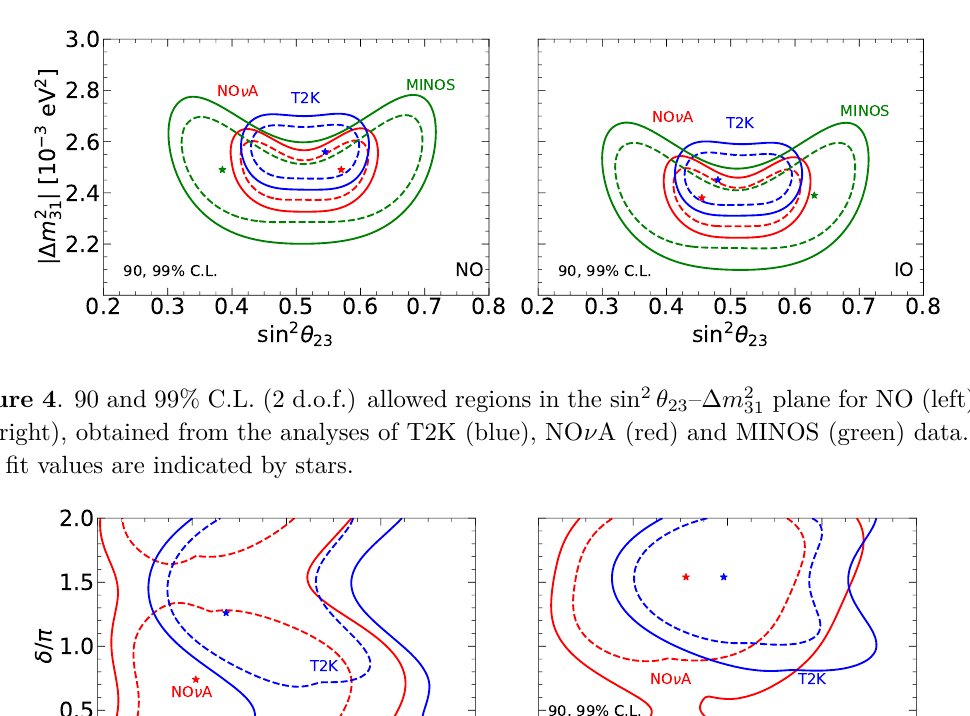
Figure 5 . 90 and 99% C.L. (2 d.o.f.) allowed regions in the sin 2 θ 13 – δ plane for NO (left) and IO (right), obtained from the analyses of T2K (blue) and NO ν A (red) data. The best fit values are indicated by